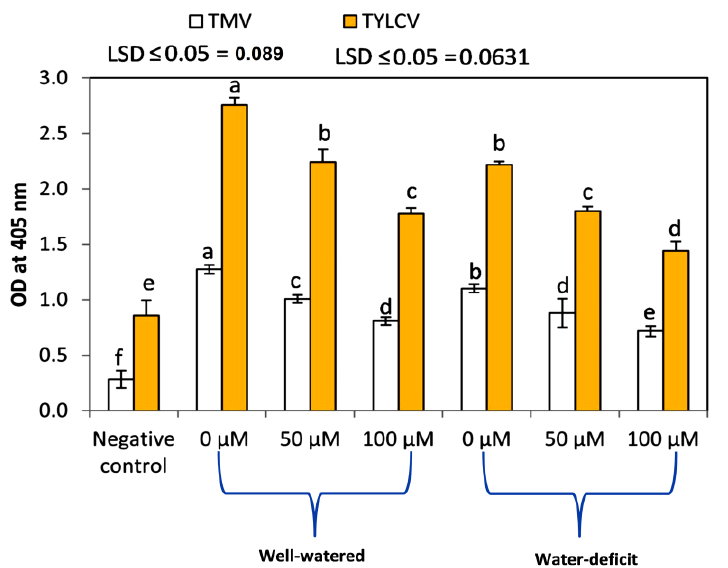
Figure 8. Effects of SNP as a foliar application on the relative concentrations of TMV and TYLCV using the ELISA technique on tomato plants grown under two different irrigation regimes at 10 WAT. Data followed by the same letters are not significantly different using the LSD multiple rang test at a 5% level.